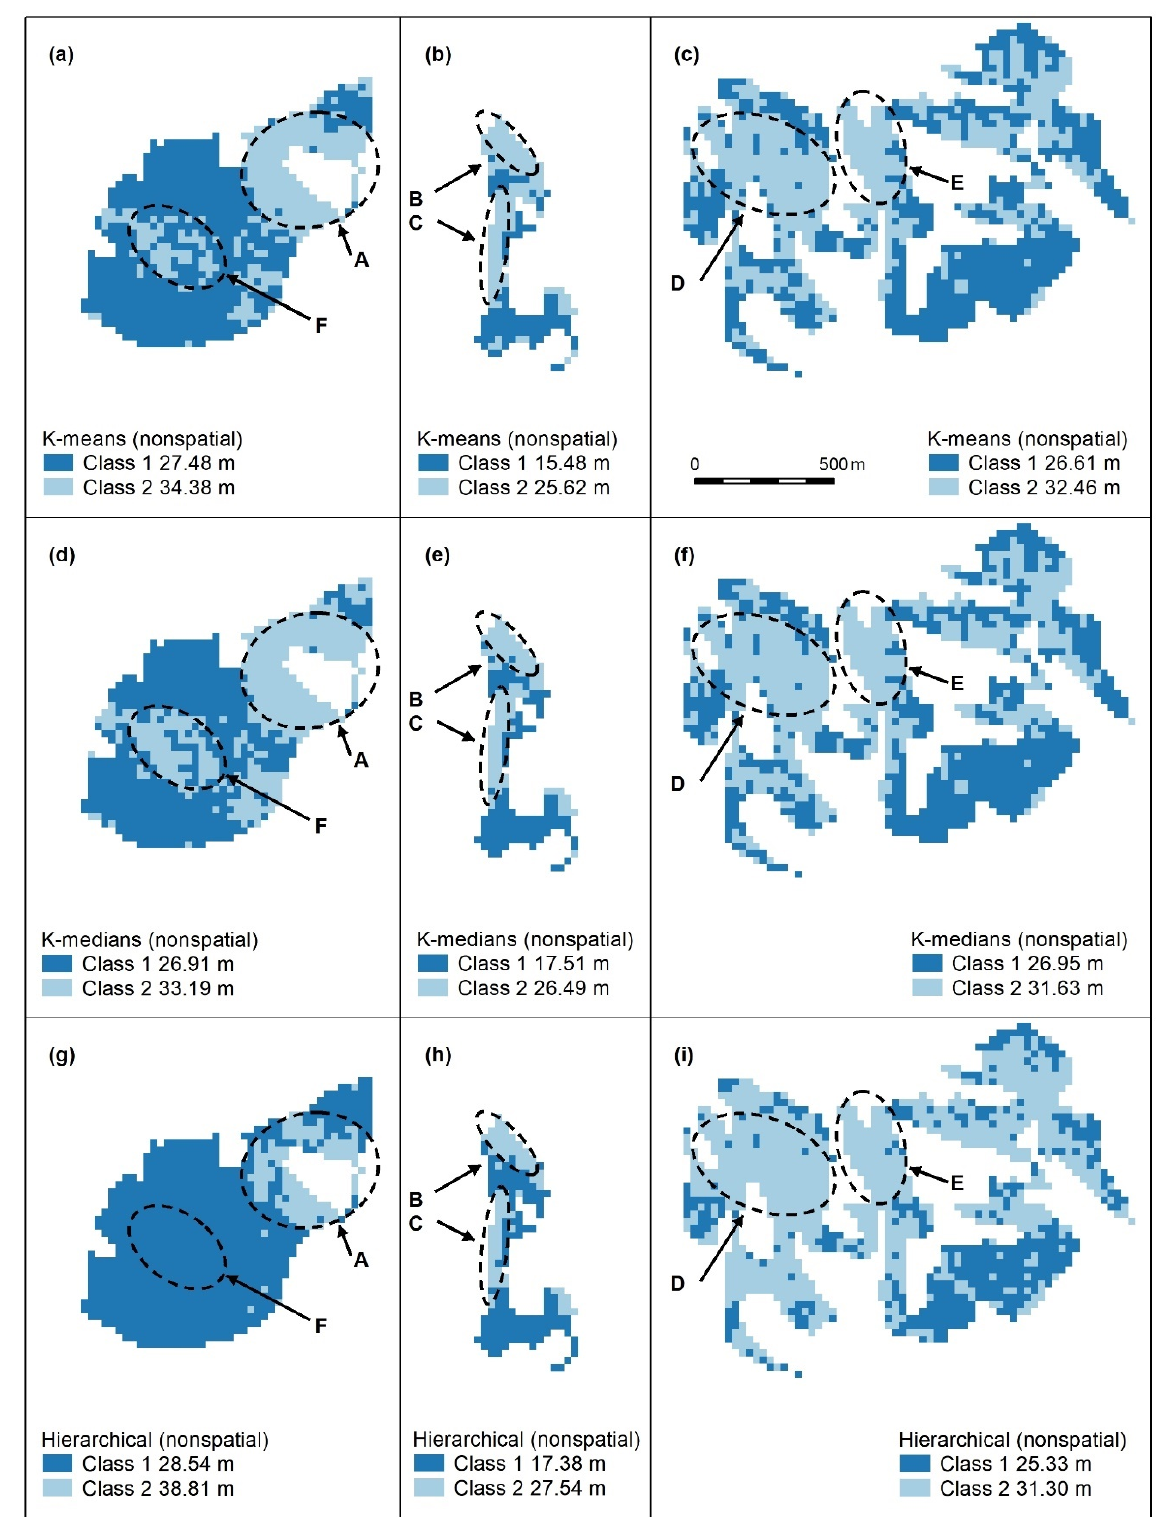
Figure A2. Nonspatial algorithms with 2 classes, using K ‐ means ( a – c ), K ‐ medians ( d – f ) and nonspatial hierarchical clustering ( g – i ). Letters A–F indicate areas of higher canopy. features A–E are captured. K ‐ medians best captures the areal extent of these features and best captures F, an unmapped area of the koala food tree Eucalyptus tereticornis ( d ). Panel scores: K ‐ means = 16, K ‐ medians = 17, and Hierarchical = 12.